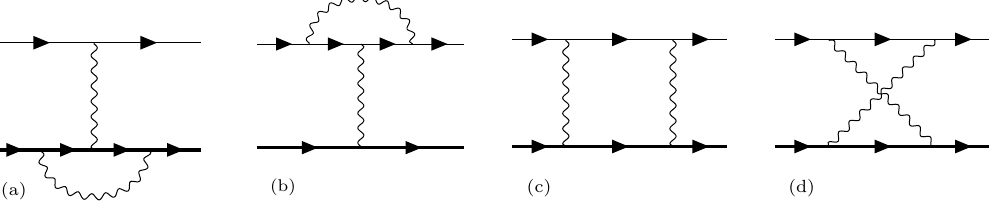
Figure 3. NLO virtual photonic